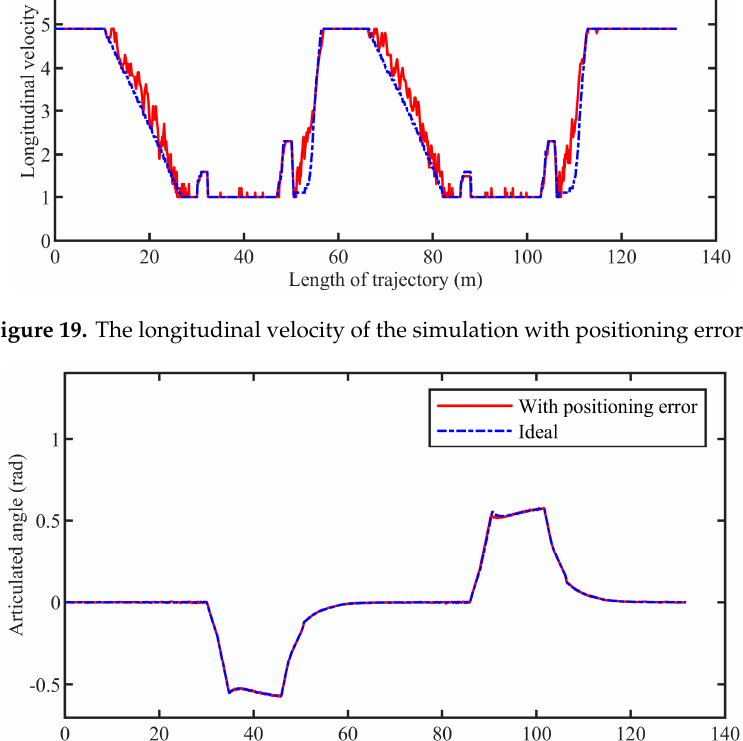
Figure 21. Articulated angle speed of the simulation with positioning errors. Figure 22. Displacement error of the simulation with positioning errors.